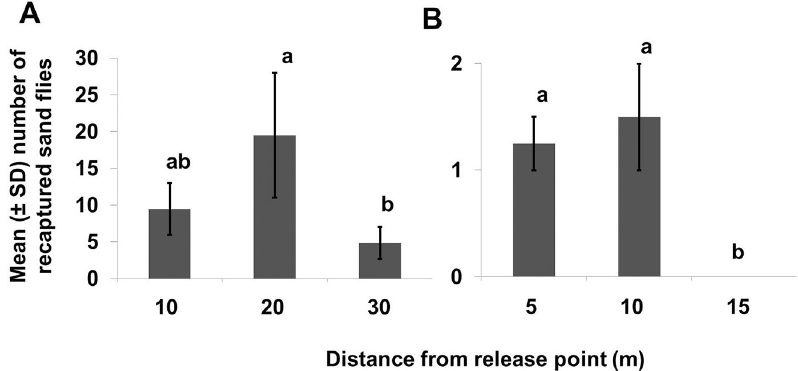
Fig 5. Number of recaptured Lu . longipalpis sand flies trapped at different distances from the release point in household (A) and household (B). The mean ± SD sand flies (males + females) for each distance from the release point was calculated from a total of two replicates (corresponding to the experiments marked with lime and pink fluorescent powders). The mean numbers of recaptured sand flies shown in bars with the same letters were not significantly different from each other ( P <